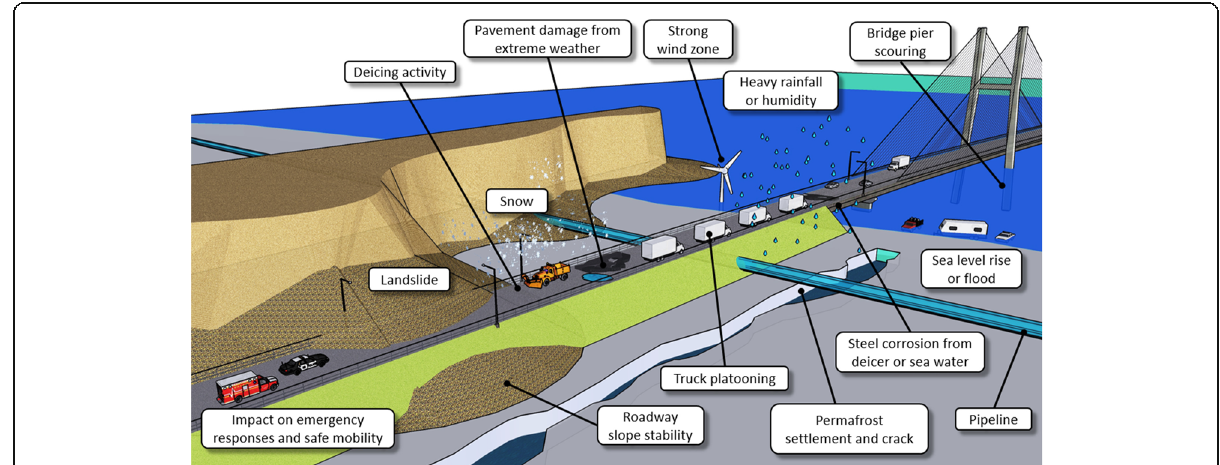
Fig. 2 Multiple challenges requiring the preservation and resilience of transportation